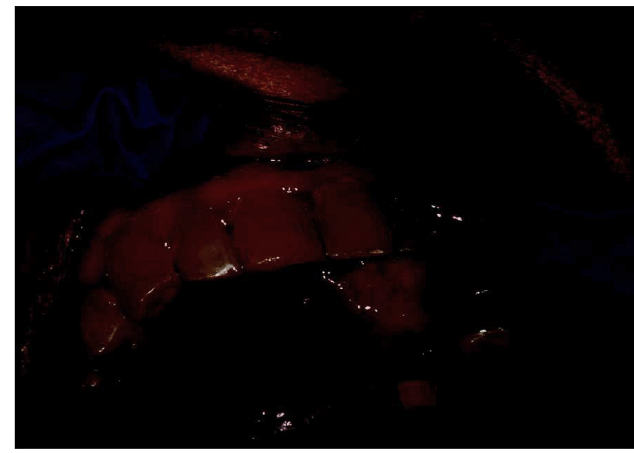
Fig. 5. Development of lesions following the decision to perform